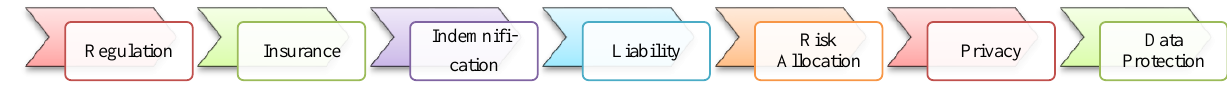
Figure 8. Challenges related to AI practices within the legal